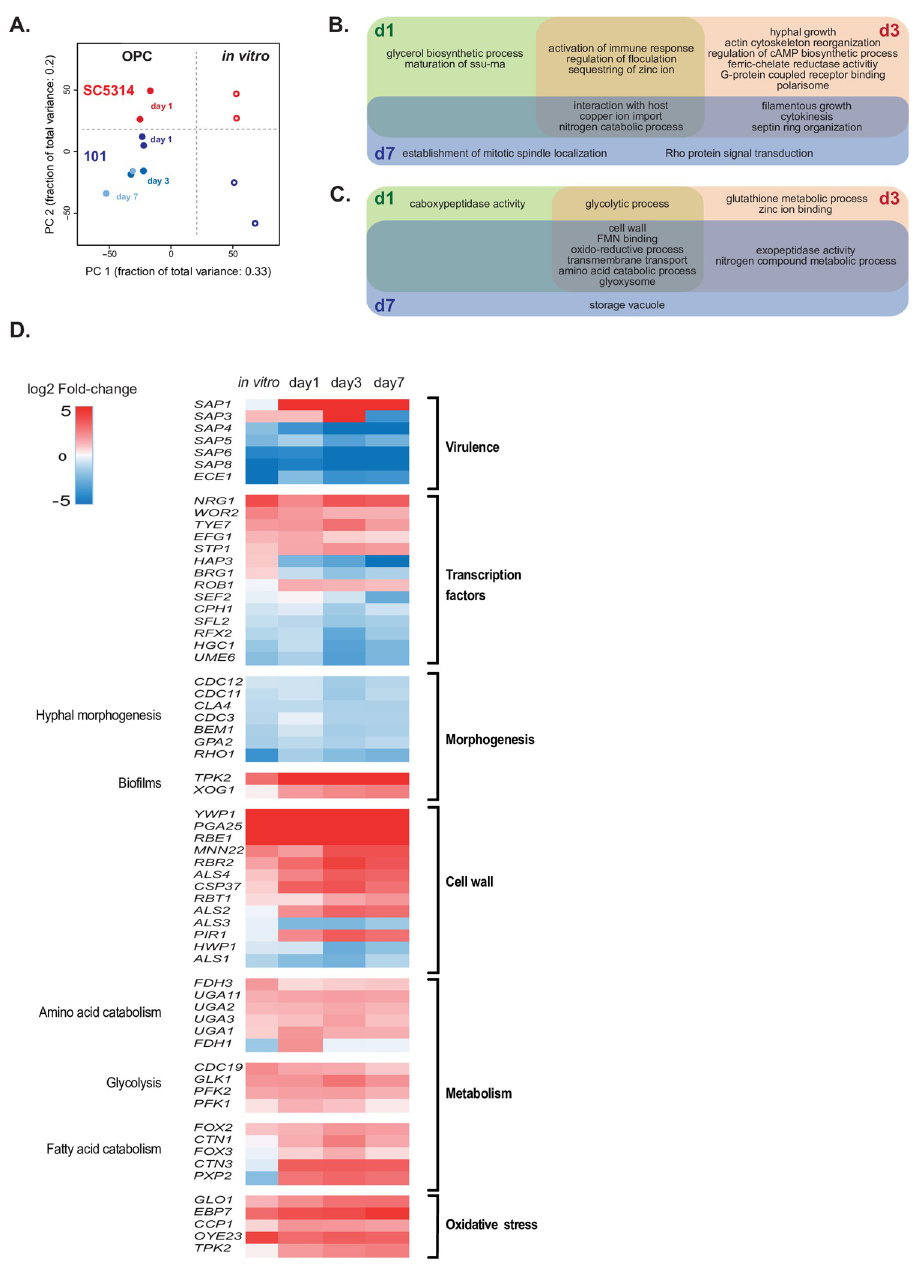
Fig 4. Persistence of isolate 101 in the oral mucosa is associated with a reduced virulence profile and an altered metabolic signature. A. PCA plot generated from the 5589 C . albicans genes that were detected in the RNAseq analysis. B-C. Venn diagram showing the GO terms associated with genes that were down-regulated ( B ) or up- regulated ( C ) in isolate 101 on day 1 (green), day 3 (red) and/or day 7 (blue) post-infection in comparison to SC5314 on day 1 post-infection. Only genes with p-values below 0.05 and log2 fold change � 1 and � -1 were considered. D. Heat map of selected differentially regulated genes linked to virulence, morphogenesis, cell wall and metabolism (p < 0.05). Genes are displayed by decreasing log2 fold-change for the ‘ in vitro ’ condition (101 in vitro vs. SC5314 in vitro). day 1, 101 in vivo day 1 vs. SC5314 in vivo day 1; day 3, 101 in vivo day 3 vs. SC5314 in vivo day 1; day 7, 101 in vivo day 7 vs. SC5314 in vivo day 1. Please see also S2 and S3 Figs .